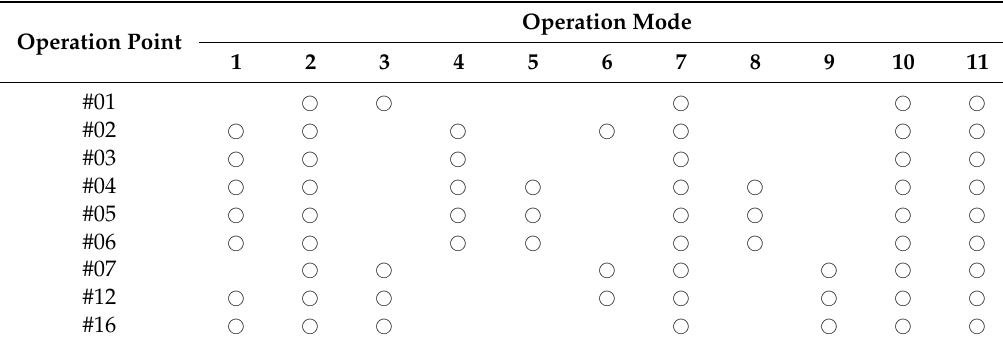
Table 5. Operation modes and measurement